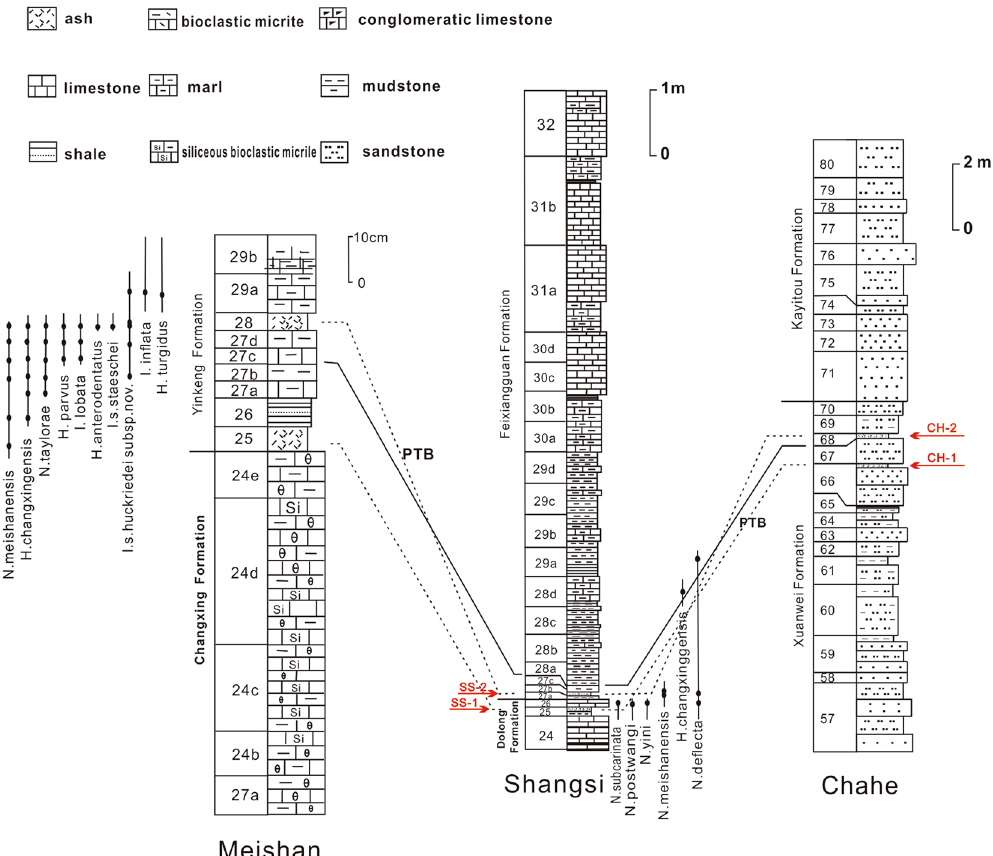
Figure 1. Lithological columns of the correlation and sampling horizons of the studied sections. Meishan section is the standard P-T profile. Red arrows point out the corresponding studied beds. Lithological columns of Meishan and Shangsi are referenced from Jiang